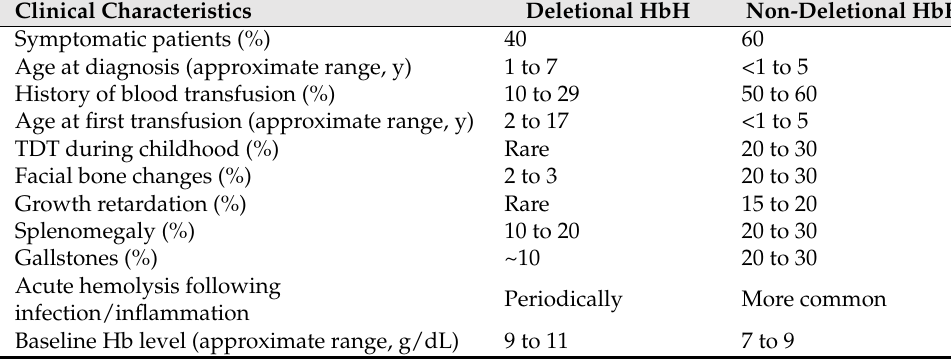
Table 1. Comparison of clinical characteristics between patients with deletional and non-deletional HbH. Clinical Characteristics Deletional HbH